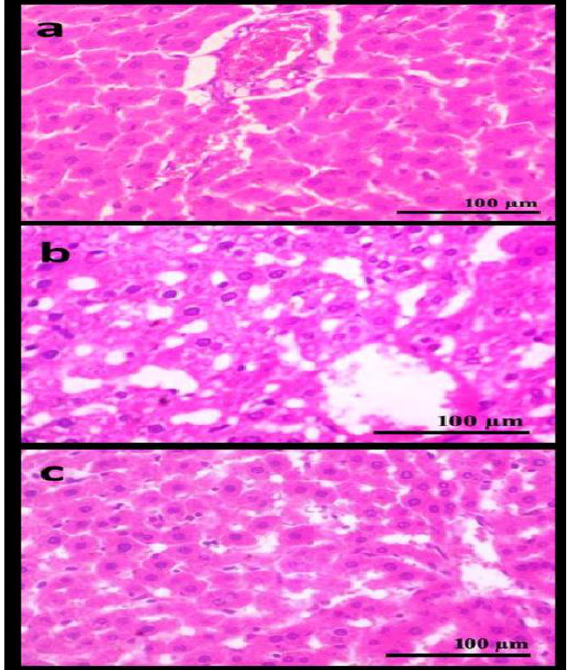
Figure 3. Histological sections of rat liver sections stained with hematoxylin and eosin (original magnification ×200) from each group: G1: Regular diet (R.D.); G2: High-fat diet (HFD); G5: HFD+ combination of Spirulina maxima extracts and Lactobacillus casei ATCC 7469-fermented wheat bran extract ( a ) G1: liver tissue section showed normal histological structure of hepatic lobules (H&E ×200); ( b ) G2: hepatic tissue section showing swelling and vacuolation of hepatocytes with microvesicular steatosis (H&E ×200); ( c ) G5: hepatic tissue section showing mild swelling of hepatocytes with foamy cytoplasm (H&E ×200).